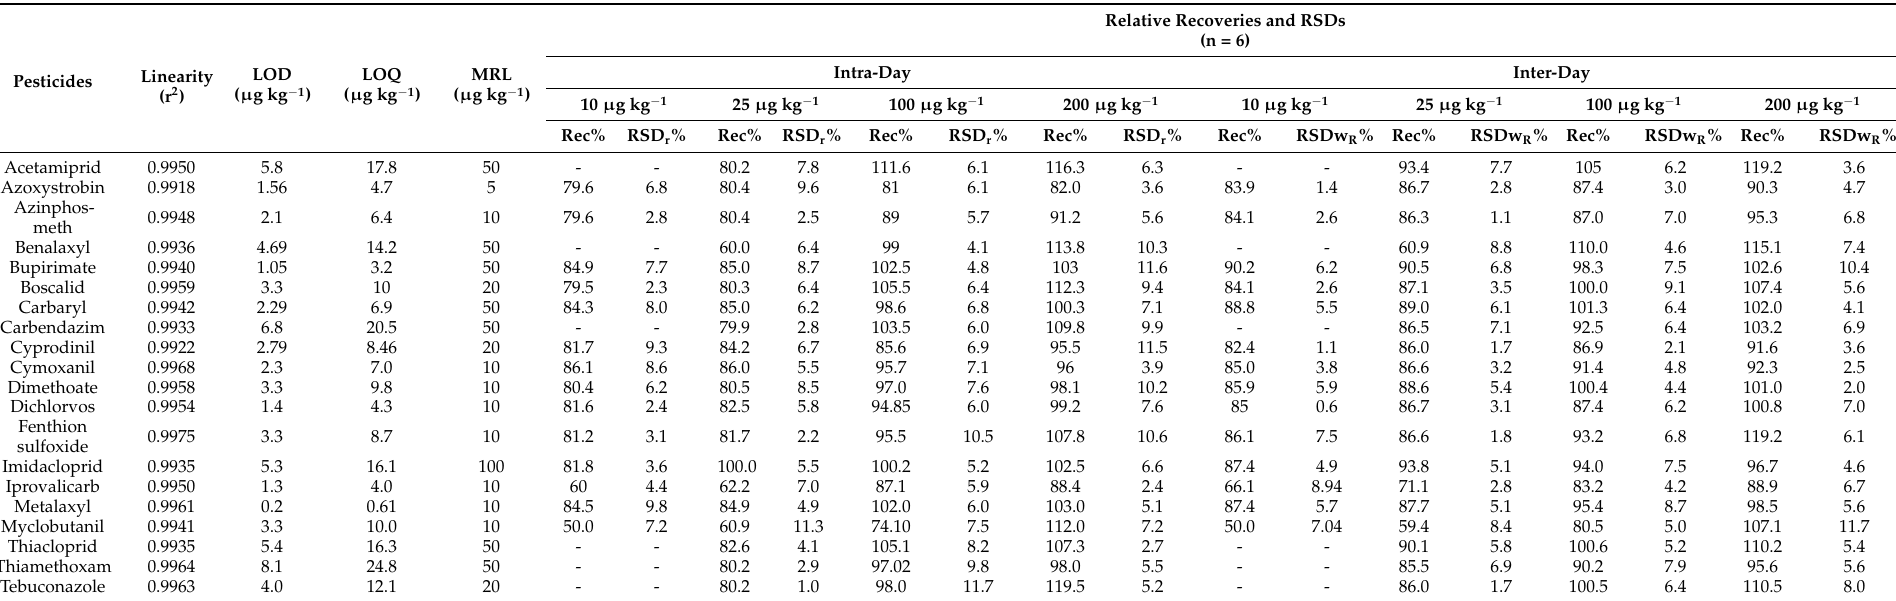
Table 2. Method validation parameters: linearity (1–250 µ g kg − 1 range), limits of detection (LODs), limits of quantification (LOQs), mean relative recoveries (%), and relative standard deviations (RSDs) (%) of four different spiked levels (n = 6) studied for intra and inter-day, as well as maximum residue levels (MRLs), for pesticide residues in